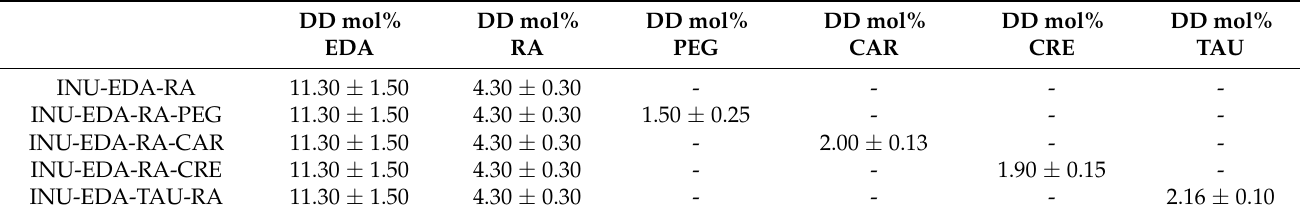
Table 1. DD mol% of EDA, RA, PEG, CAR, CRE, and TAU with reference to INU repeating units and calculated by 1 H-NMR analysis.